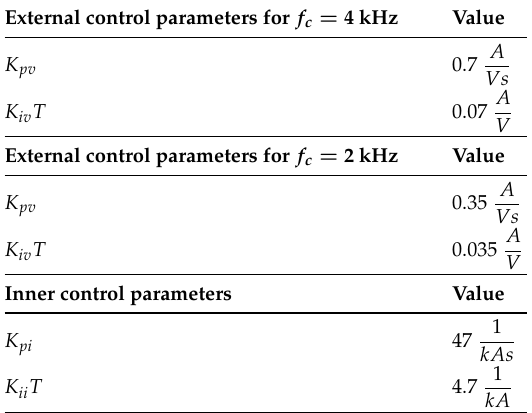
Figure 5. Simulation of output current reference i Lref , signal control u , and voltage error e v with the converter operating in steady-state: ( a ) Test 1; ( b ) Test 2; ( c ) Test 3; ( d ) Test 4. Table 2. Analog parameters controller